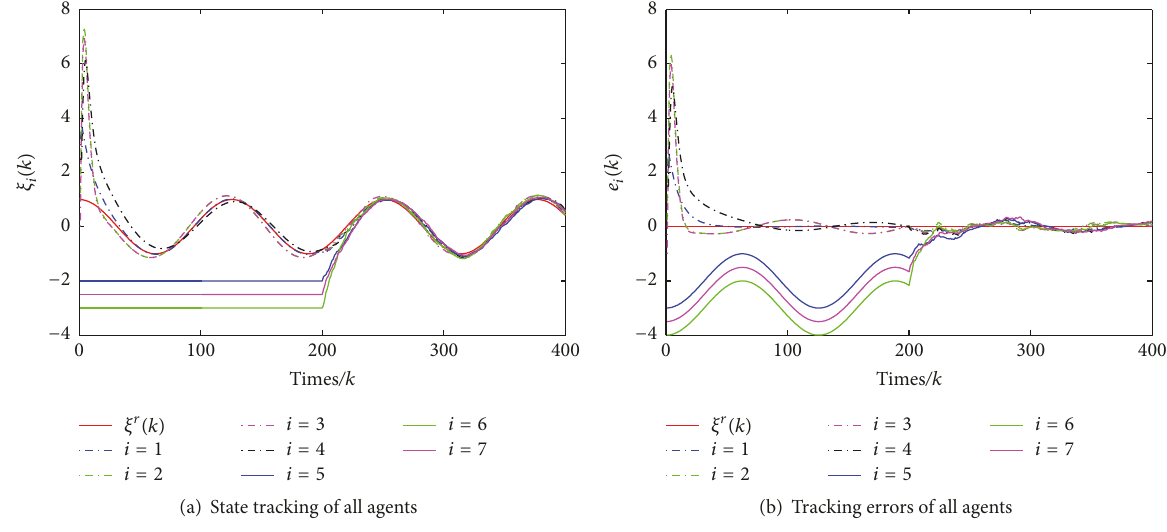
Figure 5: Simulation results in Case 3.